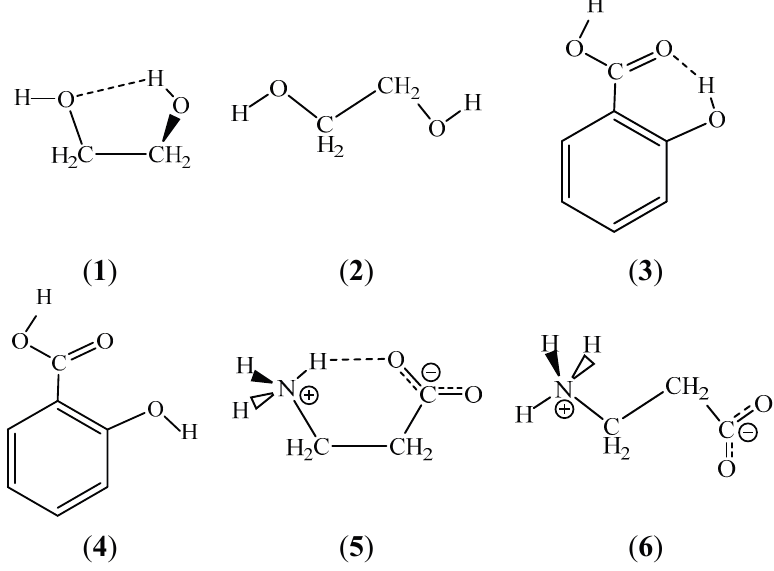
Figure 2. Structures with an intramolecular hydrogen bond for: ( 1 ) 1,2-Ethanediol; ( 2 ) Salicylic acid; ( 3 ) Hydroxy-benzoic acid; and ( 5 ) β -Alanine zwitterion. Conformations 2 , 4 , 6 prevent the formation of the intramolecular H-bond and are open for forming intermolecular hydrogen